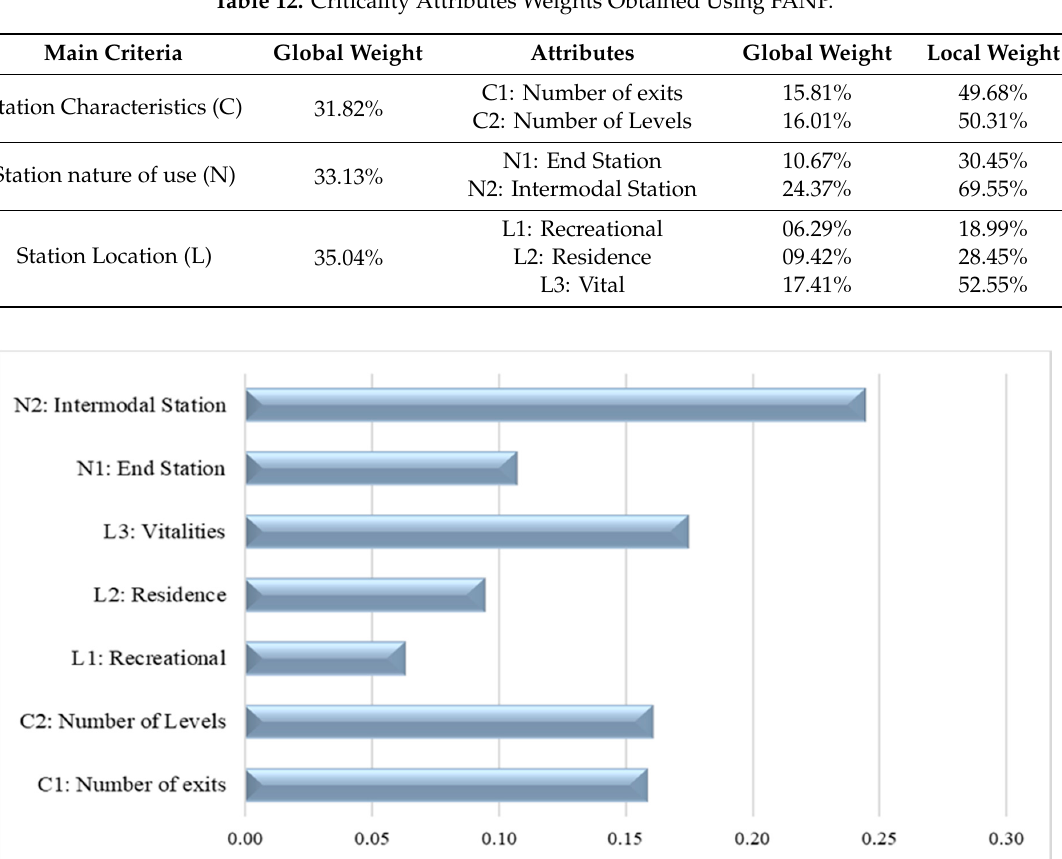
Figure 7. Criticality Index Attributes Global Weights.